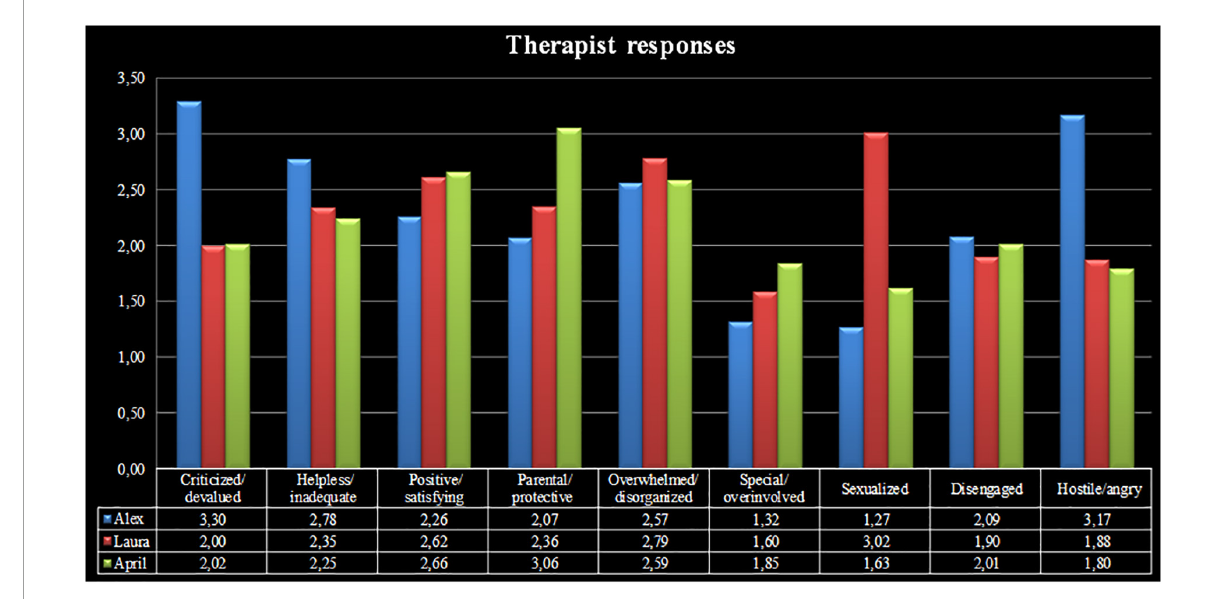
FIGURE4 Therapist responses to Alex, Laura, and April.